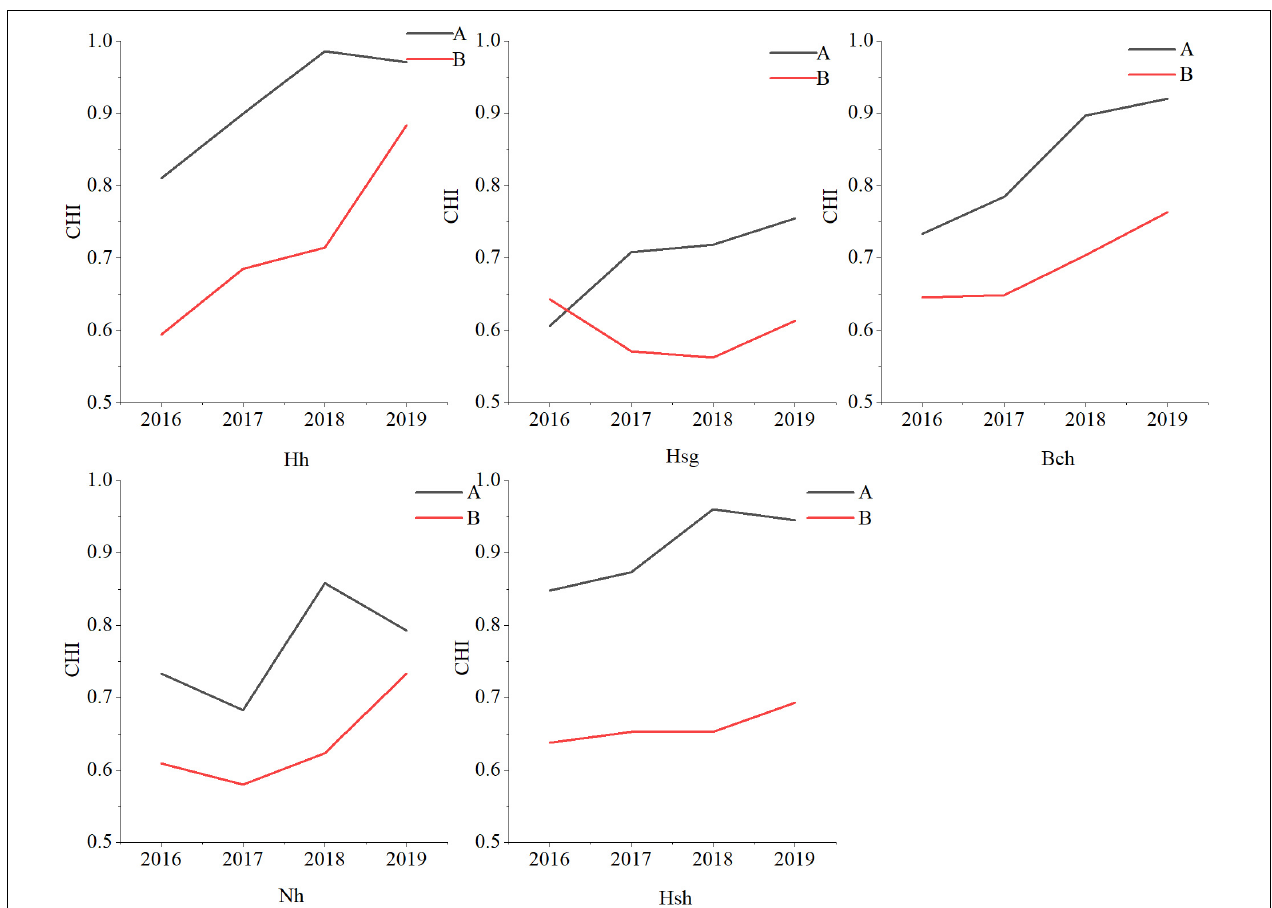
FIGURE 7 | Interannual variations of health score of wetlands in Huangshui. A represents the health score of the Huangshui wetland obtained from the PRS-BP neural network model. B represents the health score of the Huangshui wetland obtained from the ordinary PRS model. Hh (Haihu Wetland); Hsg (Huoshaogou Wetland); Bc (Beichuan Wetland); Nh (Ninghu Wetland); Hsh (Huangshuihe